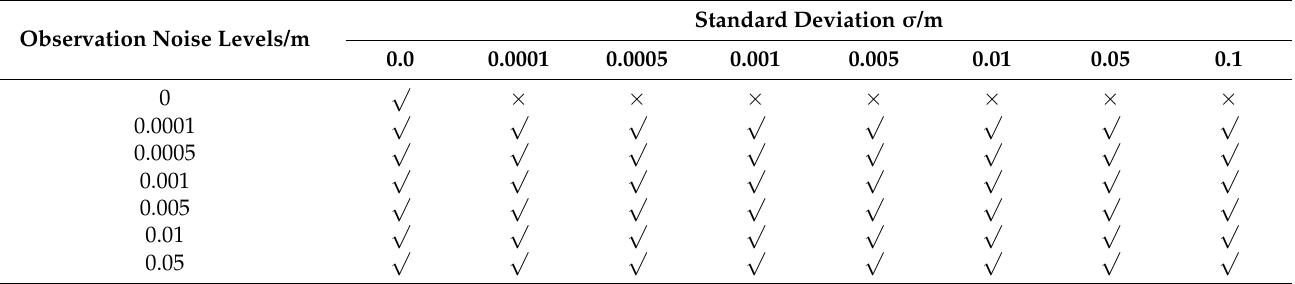
Table 1. Combination of standard deviation and observation noise levels for parameter analysis.